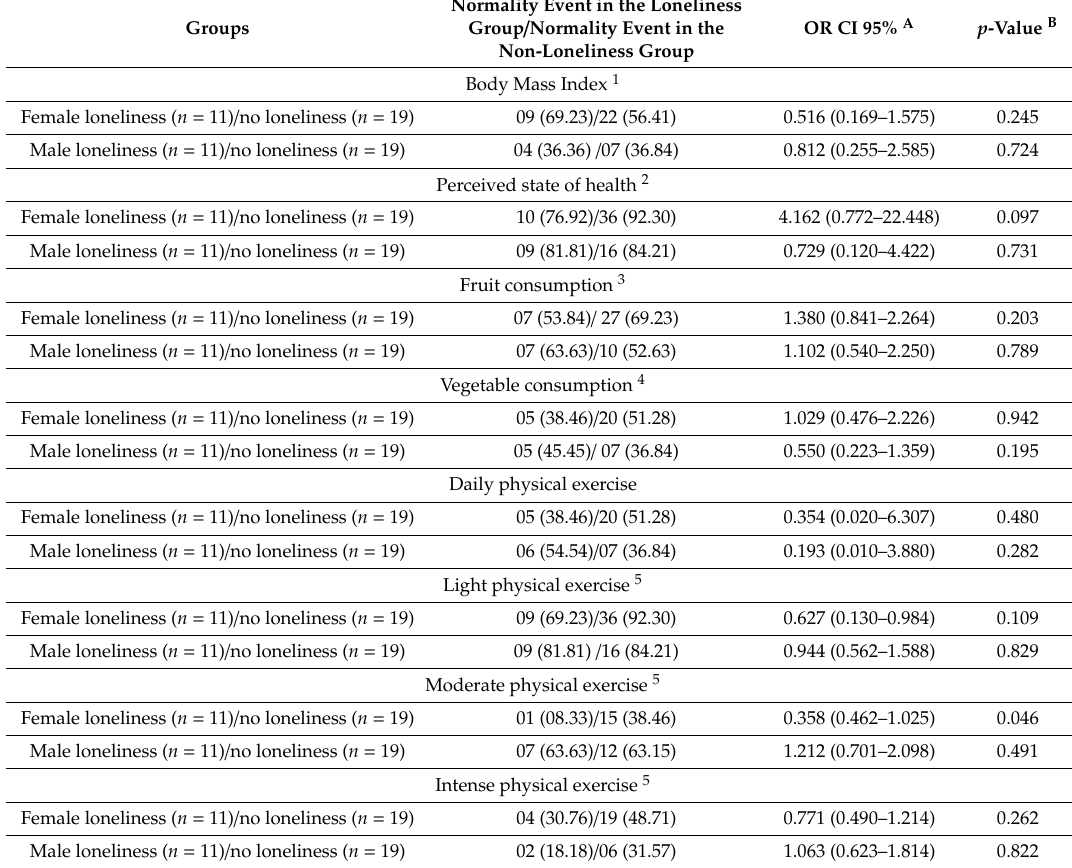
Table 2. Association of factors in women and men aged 30–44 years old who were living with other people, related to loneliness. Normality Event in the Loneliness Groups Group / Normality Event in